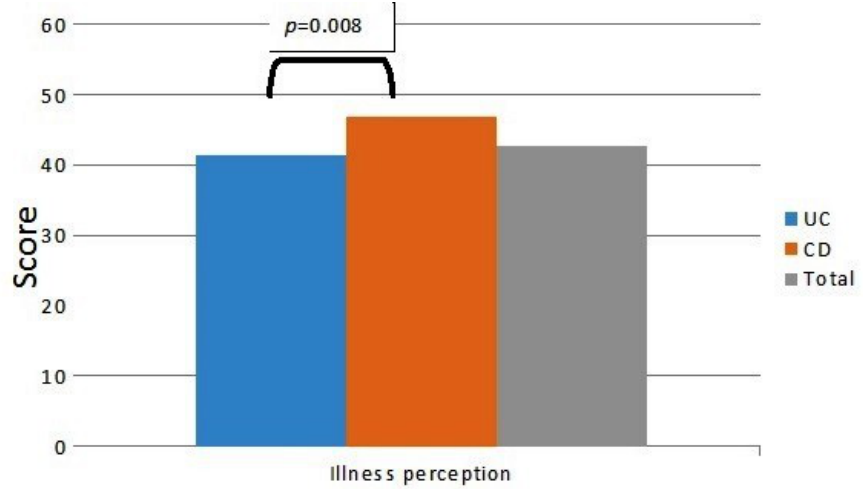
Figure 2. Illness perception overall score (mean score 42.8 ± 14.3) in the 202 IBD patients in remission ( n = 143 UC and n = 59 CD), as assessed by Brief Illness Perception Questionnaire.